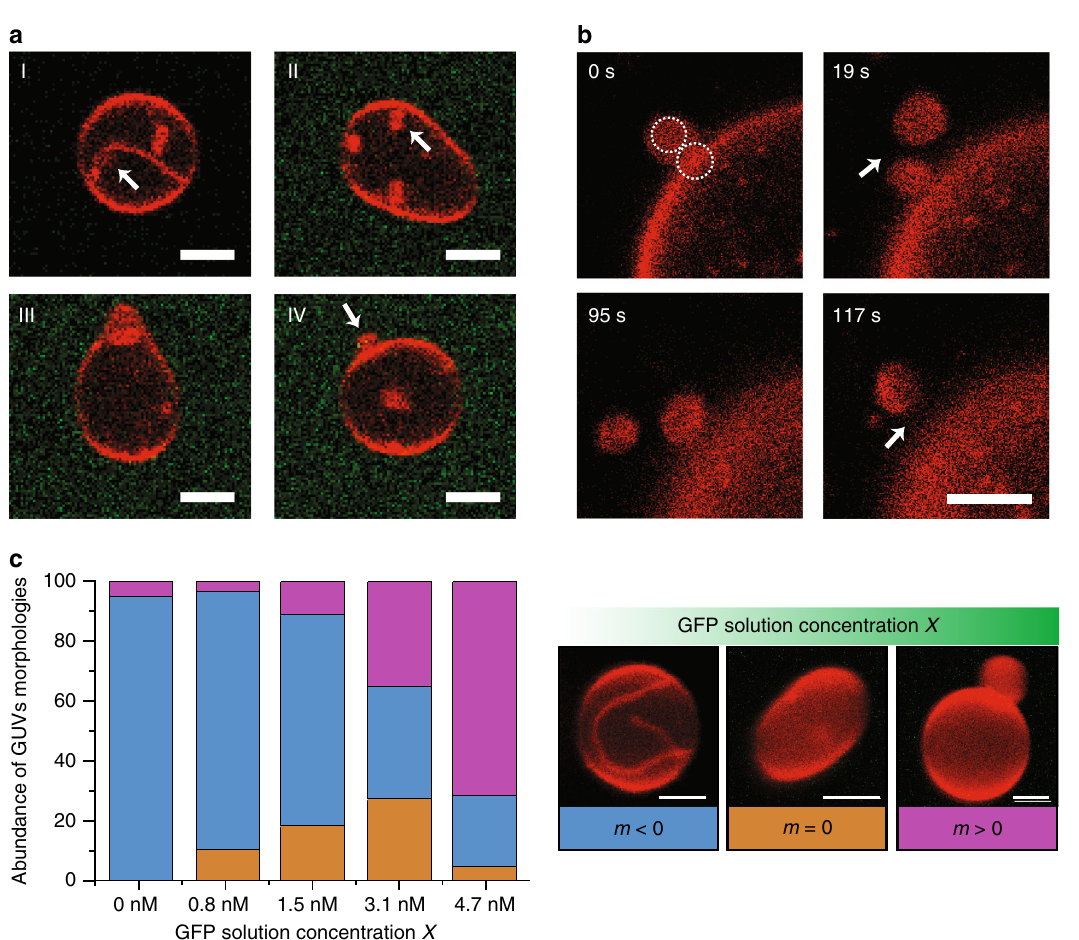
Fig. 5 Behavior of GUVs with area reservoirs provided by nanotubes. a Series of (transient) shapes observed for a single GUV when the GFP concentration was increased from X = 0 nM to X = 5.3 nM over a period of about 30 min. Initially, nanotubes (I, white arrow) protruding from the spherical mother vesicle into the vesicle interior were stabilized by negative spontaneous curvature arising from the solution asymmetry between a 300 mM sucrose solution inside the vesicle and a 150 mM NaCl + 40 mM sucrose solution outside the vesicle. The addition of GFP to the exterior solution generated a less negative spontaneous curvature that transformed the in-tubes into in-buds (II) and eventually into out-buds (III, IV). The response of another GUV exposed to the same time-dependent GFP concentration is displayed in Supplementary Fig. 9. b Time-dependent shape evolution of a single GUV exposed to the constant GFP concentration X = 7.8 nM. At time t = 0 s, the GUV exhibits a short outward-pointing necklace consisting of two small spheres (white circles) that were successively released from the GUV via neck fi ssion. The neck between the two small spheres was cleaved after about 19 s, the neck between the remaining bud and the mother vesicle after about 117 s. c Classi fi cation of stable GUV morphologies into three fractions as observed in two independent experiments: for each GFP concentration, we determined the fraction of shapes with inward-pointing membrane protrusions and total spontaneous curvature m < 0, prolate shapes with no visible protrusions and m ≃ 0, shapes with outward-pointing protrusions and m > 0 as illustrated by the three images on the right. All data displayed in the present fi gure were obtained for 1 mol% anchor-lipids. All scale bars: 5 μ m. Source data (number of vesicles per condition) for panel c are provided in the Source Data fi